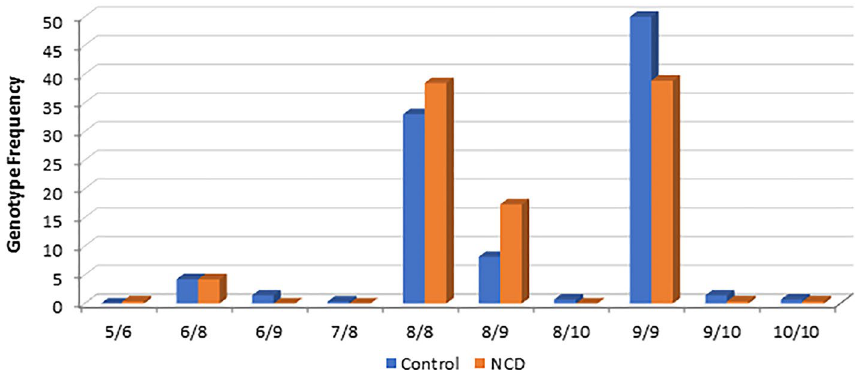
Figure 2. Genotype frequency of the SBF1 (GCC)-repeat in the human samples studied. The genotype distribution departed from HWP in both groups and was different between the two groups.